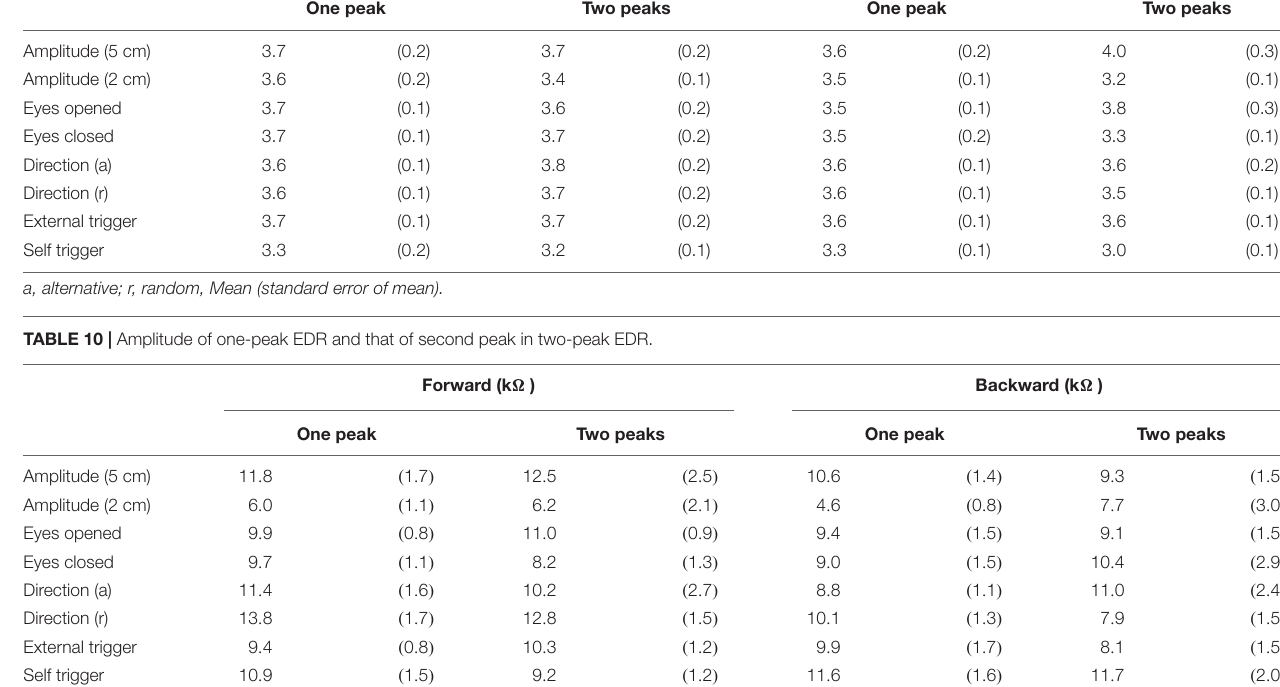
Table 10 . There was no significant difference in the amplitude between the one-peak EDR and the second peak of the two- peak